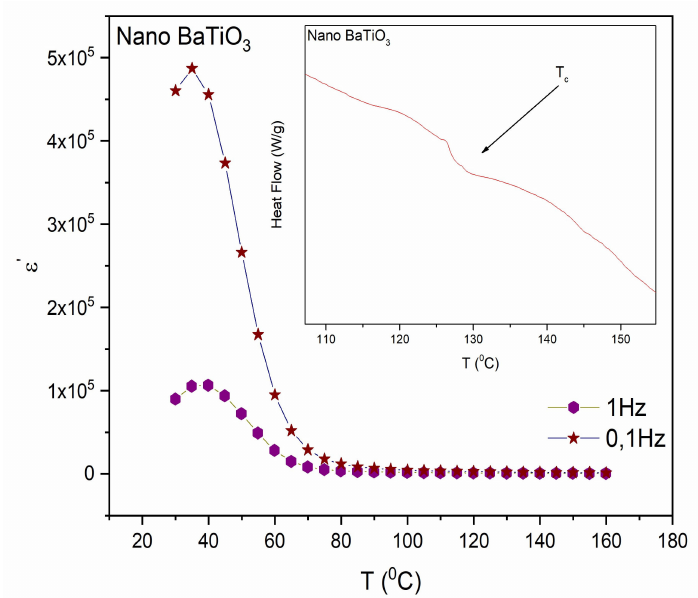
Figure 7. Real part of dielectric permittivity for nano-BT particles as a function of temperature at 1 and 0.1 Hz. Inset shows the DSC thermograph of nano-BT particles with 30 ◦ C / min heating rate, endo